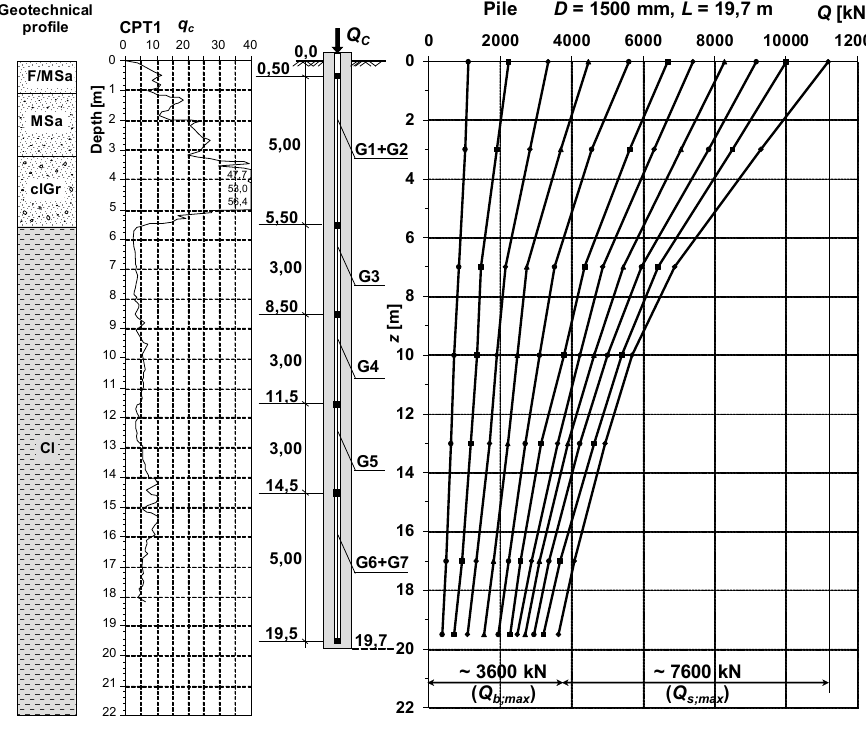
Fig. 3. Pile load distribution (G1–G5 – reading gages location)